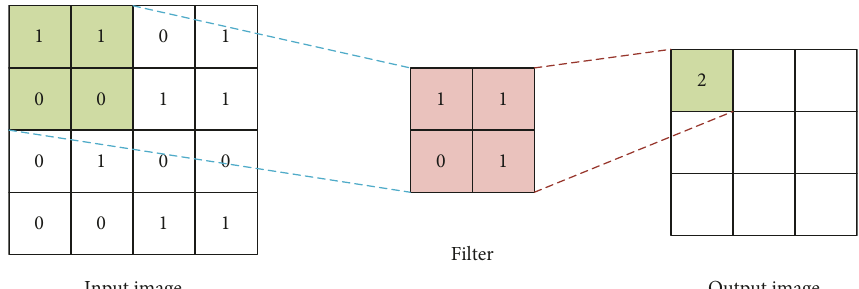
Figure 1: A simple operation process of the convolutional layer.